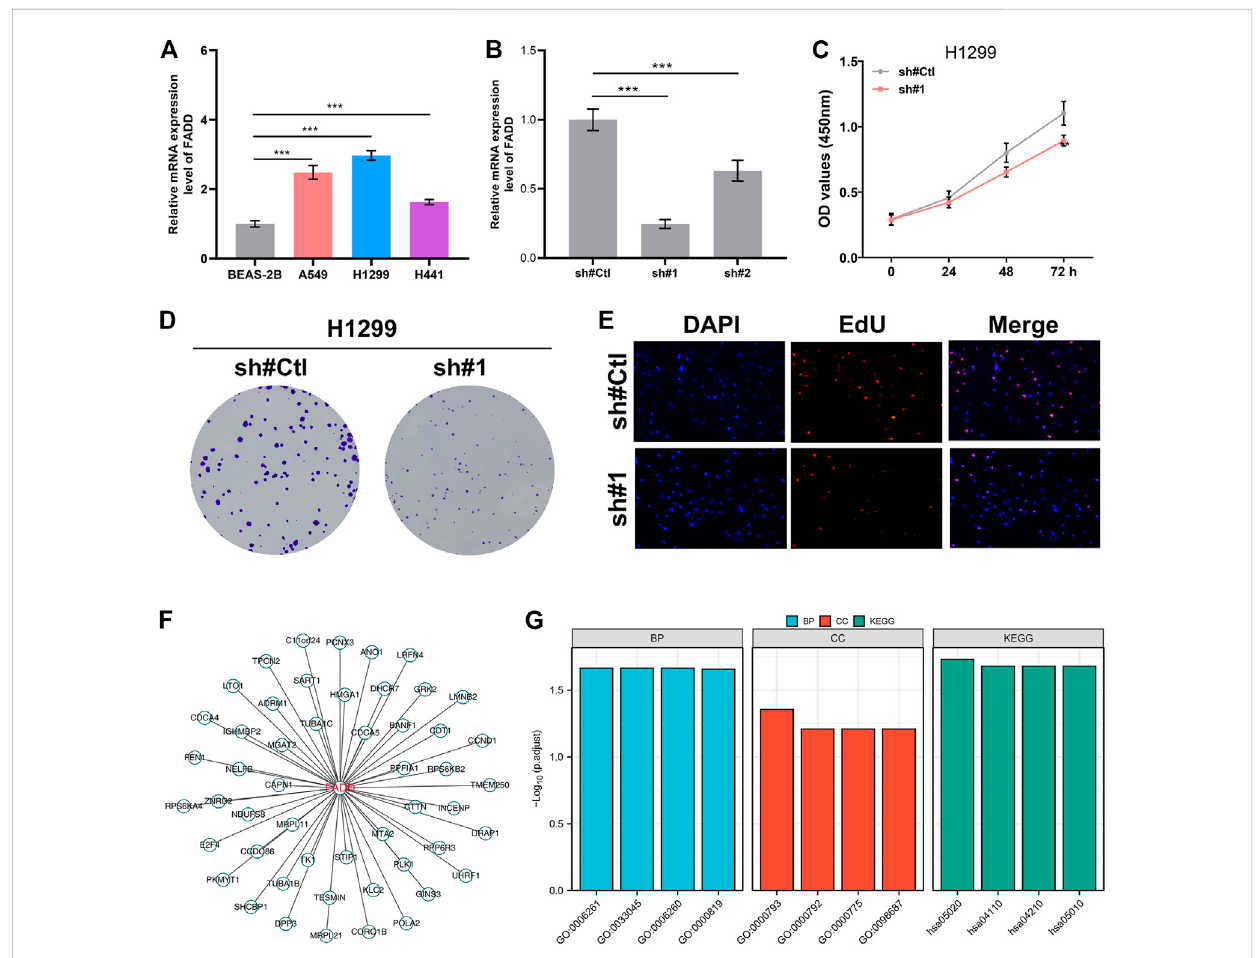
FIGURE 6 FADD enhances the cell proliferation ability of lung cancer. Notes: (A) The mRNA level of FADD in cell lines; (B) Knockdown ef fi ciency of FADD in lung cancer cells; (C) CCK8 assay was conducted between the control and FADD knockdown cells; (D) Colony formation assay was conducted between the control and FADD knockdown cells; (E) EdU assay was performed between the control and FADD knockdown cells; (F) The molecules regulated by FADD; (G) GO and KEGG analysis of FADD-regulated